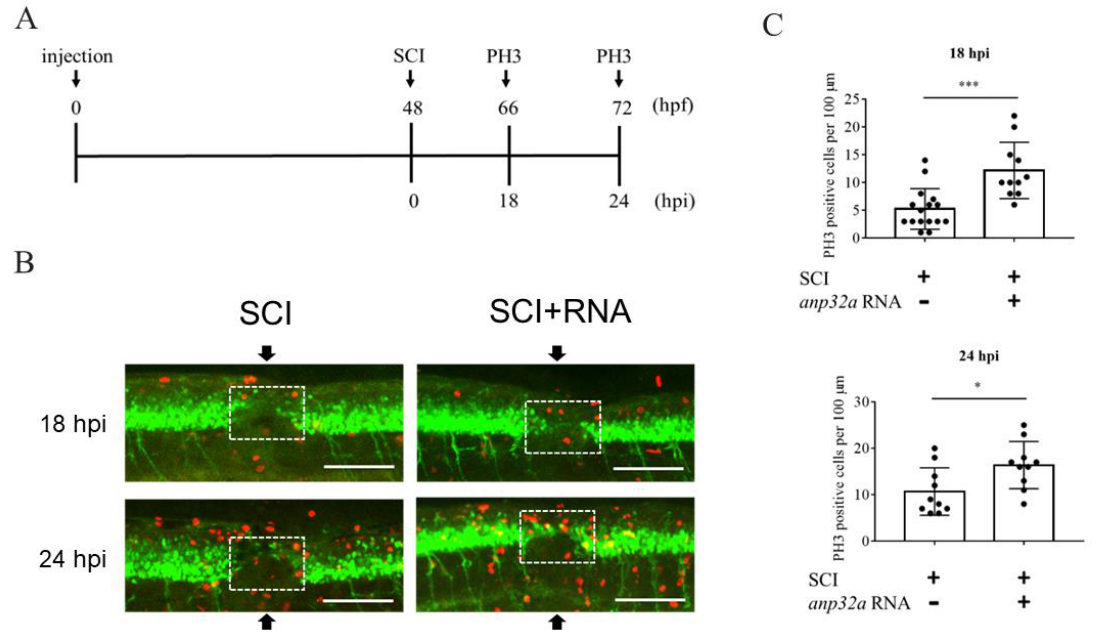
Figure 5. Overexpression of Anp32a could promote cell proliferation in SCI embryos during recovery. ( A ) The experimental flowchart. Anp32a mRNA was injected into embryos from zebrafish transgenic line Tg(mnx1:GFP) at the one-cell stage, followed by SCI at 48 hpf and staining with anti-PH3 at 18 and 24 hpi. ( B ) Proliferation patterns around the lesion site of embryos treated as indicated at 18 and 24 hpi were presented by immunofluorescence through antibody against phosphorylated histone H3 (PH3; Red) and visualized by laser confocal microscopy. Arrow indicates the SCI site, while white dotted box indicates the calculation area. ( C ) Statistical count of PH3-positive cells between SCI- Anp32a -overexpressed embryos ( n = 11 at 18 hpi; n = 10 at 24 hpi) and SCI embryos without overexpression of Anp32a ( n = 11 at 18 hpi; n = 10 at 24 hpi). A) Scale bar: 100 µ m. The Student’s t -test was used to perform statistical analysis (*, p < 0.05; p < 0.01; ***, p < 0.001; error bars indicate mean ±